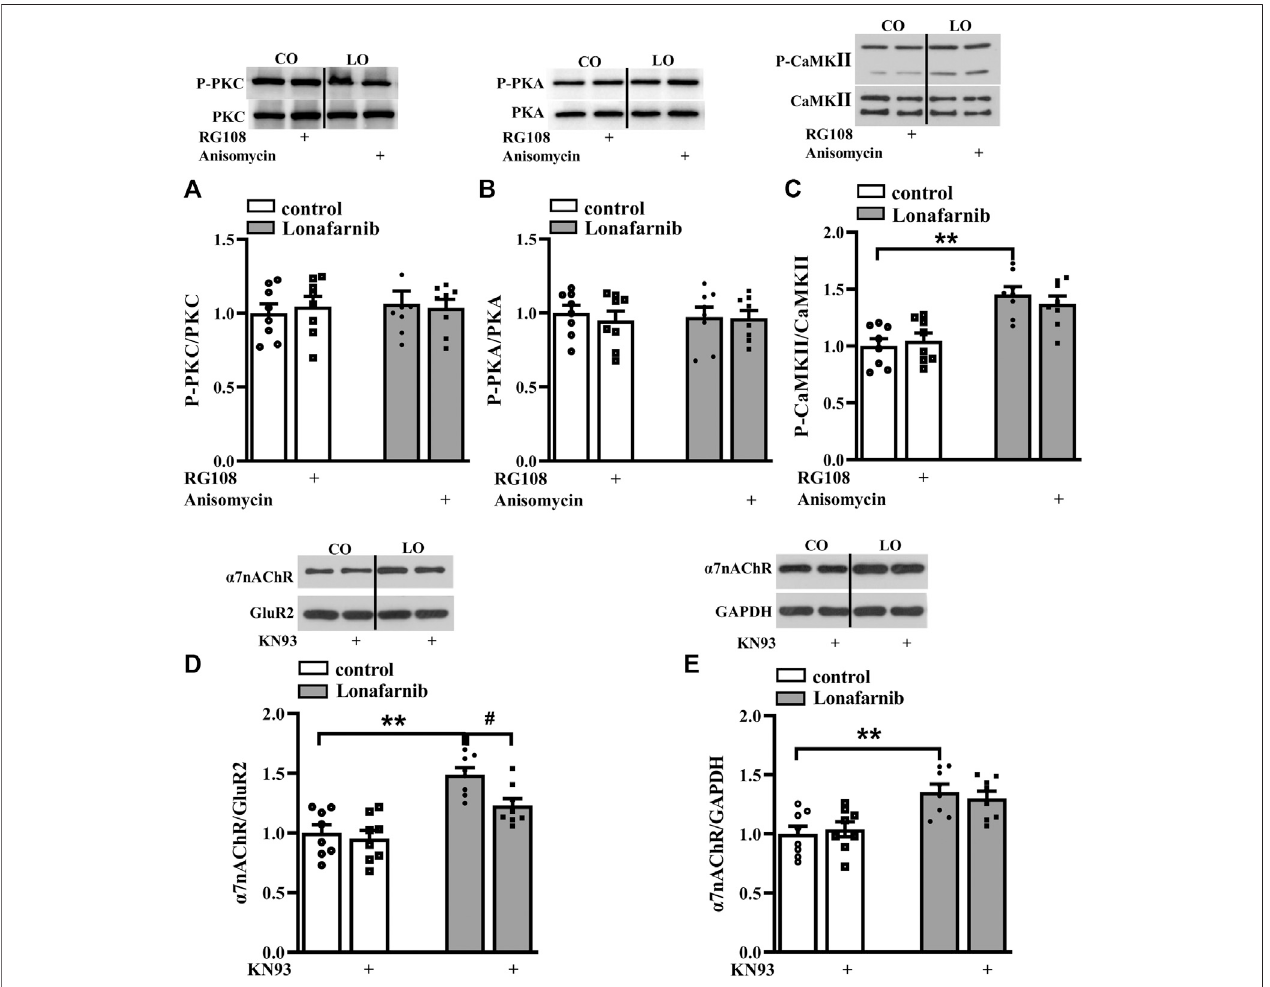
FIGURE 5 | Lonafarnib administration affects CaMKII signaling pathways, partially modulating the membrane expression of a7nAChR. (A and B) Levels of phospho-PKCandphospho-PKAinthehippocampusofcontrolandlonafarnib-treatedmicetreatedwithvehicle,RG108,oranisomycin. (C) Levelsofphospho-CaMKII inthehippocampusofcontrolandlonafarnib-treatedmicetreatedwithvehicle,RG108,oranisomycin.** P < 0.01vs.controlmice(two-wayANOVA,followedbyTukey ’ s multiplecomparisontest). (D) Levelsofbiotinylateda7nAChR(membrane)proteininthehippocampusofcontrolandlonafarnib-treatedmicetreatedwithvehicleor CaMKII pathway blocker KN93. Surface a7nAChR was normalized by surface GluR2 protein, which was again normalized by vehicle-treated control group. ** P < 0.01 vs. control mice; # P < 0.05 vs. lonafarnib-treated mice (two-way ANOVA, followed by Tukey ’ s multiple comparison test). (E) Levels of a7nAChR total proteins in the hippocampus of control and lonafarnib-treated mice treated with vehicle and KN93, and total a7nAChR was normalized by GAPDH, which was again normalized by vehicle-treated group. ** P < 0.01 vs. control mice (two-way ANOVA, followed by Tukey ’ s multiple comparison test). The expression of protein was normalized by the values of control group with